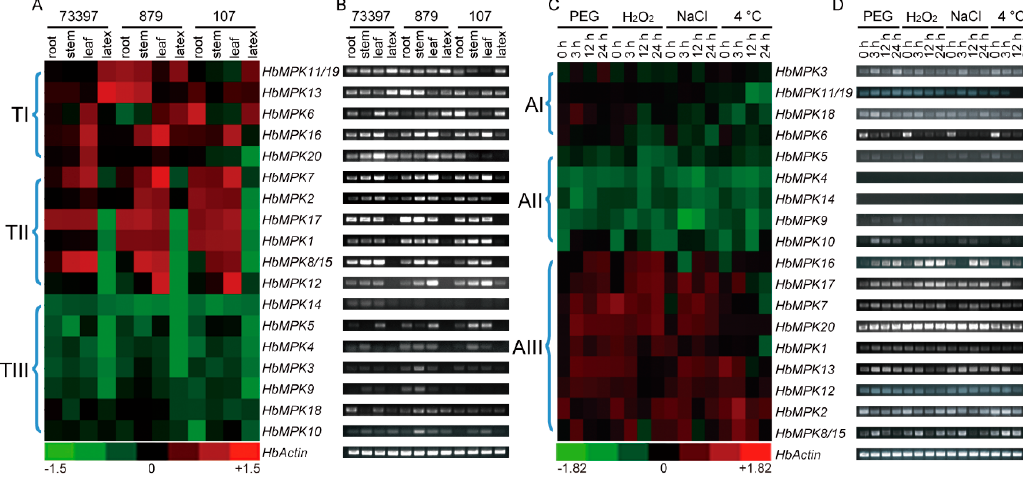
Figure 8. Expression profiles of HbMPKs in different tissues and stresses obtained from three cultivated varieties of rubber tree. Expression patterns of HbMPKs in different tissues from different cultivated varieties were determined using quantitative real-time PCR (qRT-PCR) ( A ), and semi-quantitative PCR ( B ). Moreover, heat map of qRT-PCR ( C ) and electrophoretogram of semi-quantitative PCR results ( D ) for 20 HbMPKs at 0 h, 3 h, 12 h, and 24 h under osmotic (polyethylene glycol, PEG), oxidative (H 2 O 2 ), salt (1 M NaCl), and cold (4 °C) stresses are shown. The colour bar at the bottom indicates the log 2 value of the expression fold change compared with that of the HbActin reference gene. The genes were ordered by the cluster of their expression patterns.